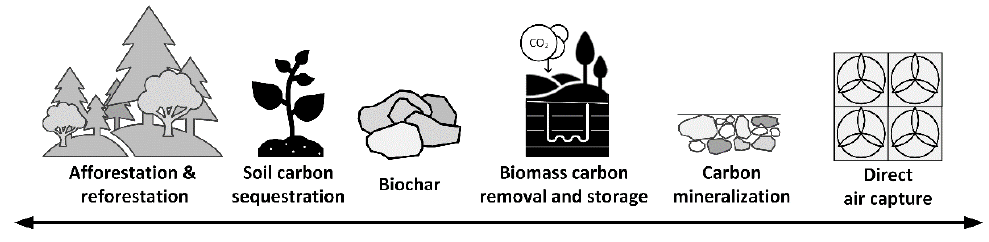
Figure 1. Carbon removal approaches in land (adapted from [2]).